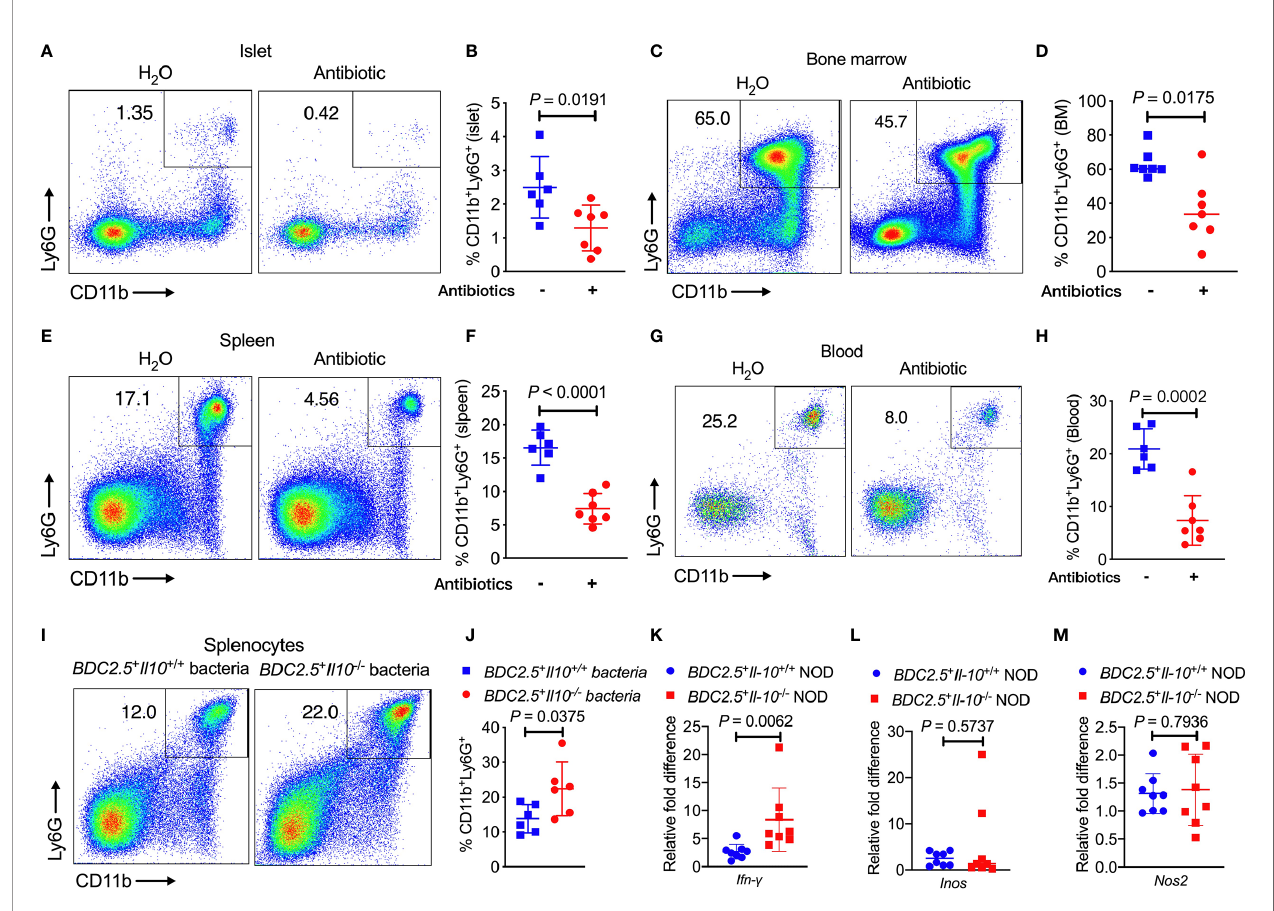
FIGURE 6 | BDC2.5 + Il-10 -/- NOD gut bacteria modulate neutrophil homeostasis. (A – H) BDC2.5 + Il-10 -/- NOD mice showed altered percentages of neutrophils after antibiotic treatment ( n = 6-7/group). Representative fl ow cytometric pro fi les, and summary of CD11b + Ly6G + neutrophils in the islets gated from CD45 + immune cells (A, B) , in the bone marrow gated from TCR b - cells (C, D) , in the spleen gated from TCR b - cells (E, F) , and in the blood gated from live cells (G, H) . (I, J) Proportion of CD11b + Ly6G + neutrophils in the splenocytes stimulated with heat-inactivated gut bacteria from either BDC2.5 + Il-10 +/+ NOD mice or BDC2.5 + Il-10 -/- NOD mice ( n = 6/group). Representative fl ow cytometric pro fi les (I) , and summary of CD11b + Ly6G + neutrophils gated from TCR- b - cells (J) . (K – M) Gene expression of Ifn- g (K) , Inos (L) , and Nos2 (M) from puri fi ed splenic neutrophils after stimulation with heat-inactivated gut bacteria from either BDC2.5 + Il-10 +/+ NOD mice or BDC2.5 + Il- 10 -/- NOD mice ( n = 8/group). Data in (B, D, F, H, J – M) were combined from two or more independent experiments. Data in (B, F, H, J, K, M) are presented as mean ± SD and statistical analysis was performed by a two-tailed Student ’ s t -test. Data in (D, L) are presented as Median and were analyzed using a two-tailed Mann-Whitney test. P < 0.05 was considered statistically signi fi